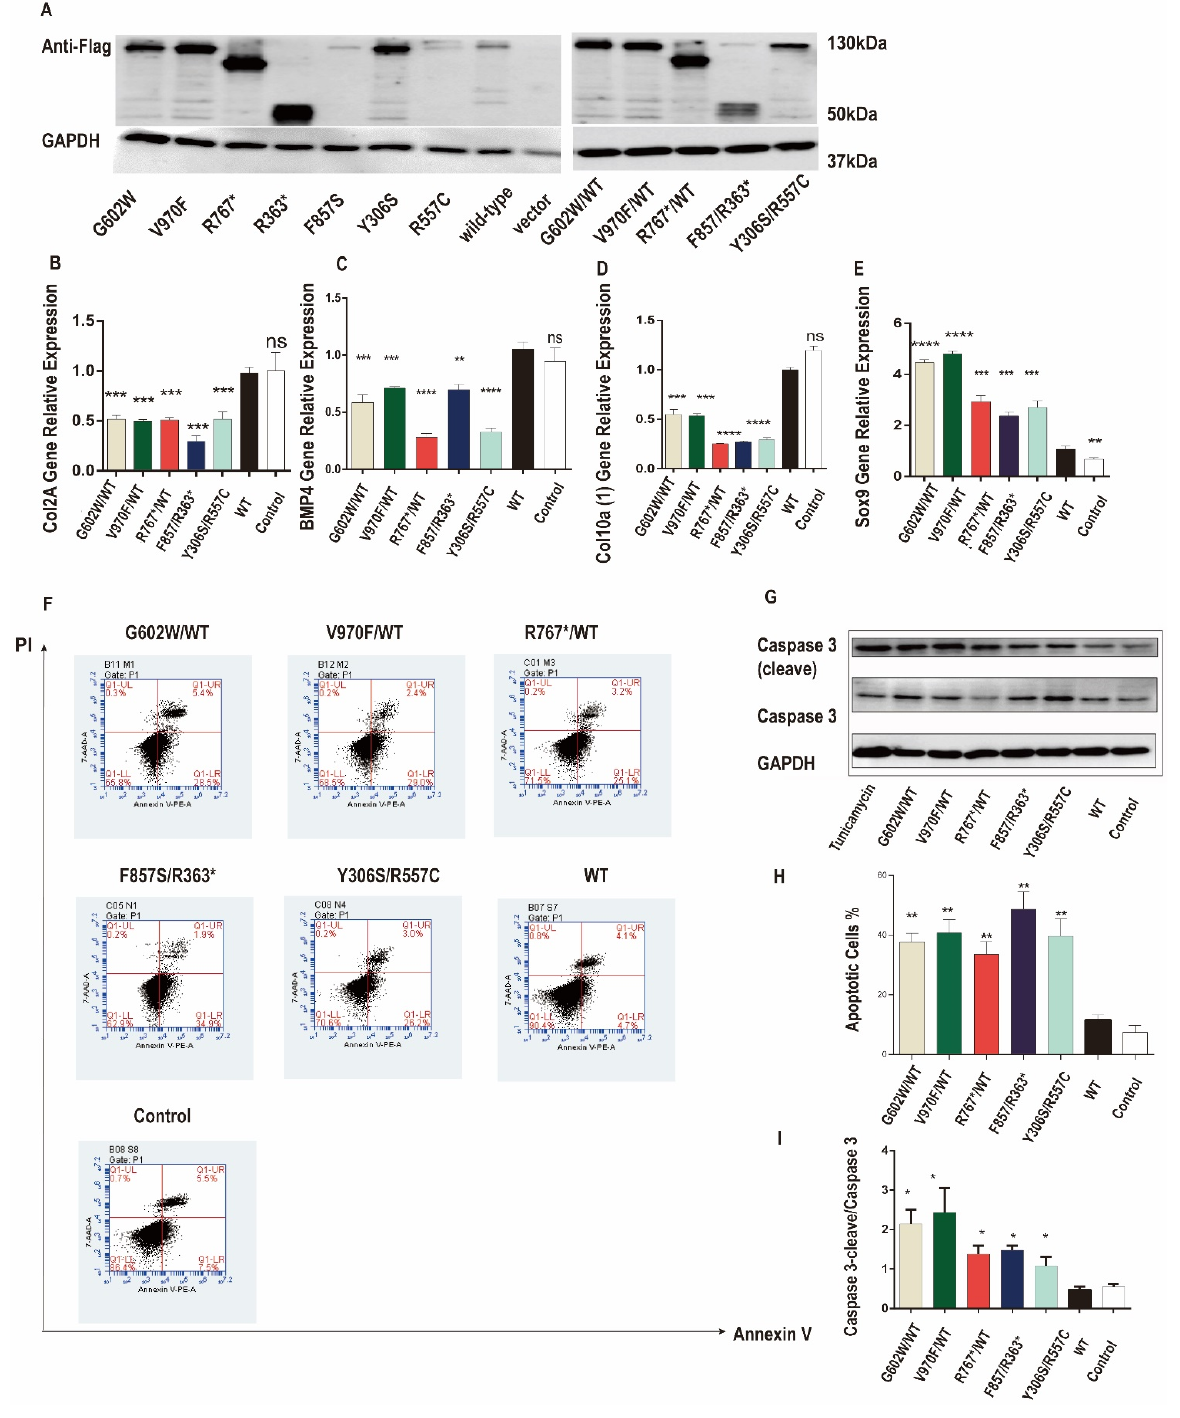
Figure 2. Natriuretic peptide receptor 2 ( NPR2 ) mutants inhibit chondrocyte differentiation and promote chondrocyte apoptosis in ATDC5 cells. ( A ) NPR2 MUT , NPR2 WT , and NPR2 vector were transfected in ATDC5 cells for 7 d. The expression of NPR2 MUT/WT protein is analyzed by Western blot. ( B – E ) Real-time polymerase chain reaction (RT-PCR) to determine mRNA levels of collagen type II alpha ( COLIIA ), type X collagen ( COLX ), bone morphogenetic protein 4 ( BPM4 ), and SRY-box transcription factor 9 ( SOX9 ) in ATDC5 cells 48 h after incubation. ( F – I ) Expression of apoptosis-related proteins is detected by Western blot and flow cytometry (Annexin V-FITC/PI). * p < 0.05, ** p < 0.01; *** p < 0.001. and **** p < 0.0001. ns—no significance. PI—propidium iodide; GAPDH— glyceraldehyde 3-phosphate dehydrogenase; WT—wild-type; FITC—fluorescein